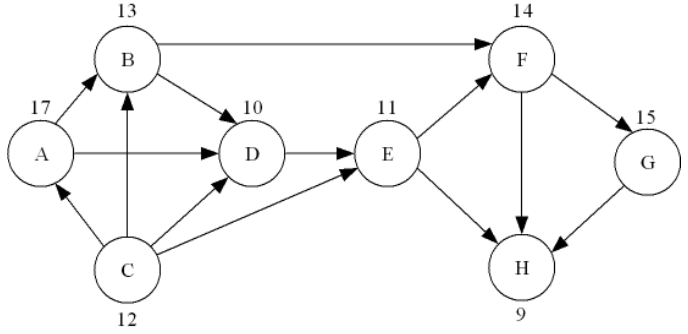
Figure 1. Sample network and execution frequency of nodes. Table 1. The analytical value of the SNA and execution frequencies of nodes in Figure 1.